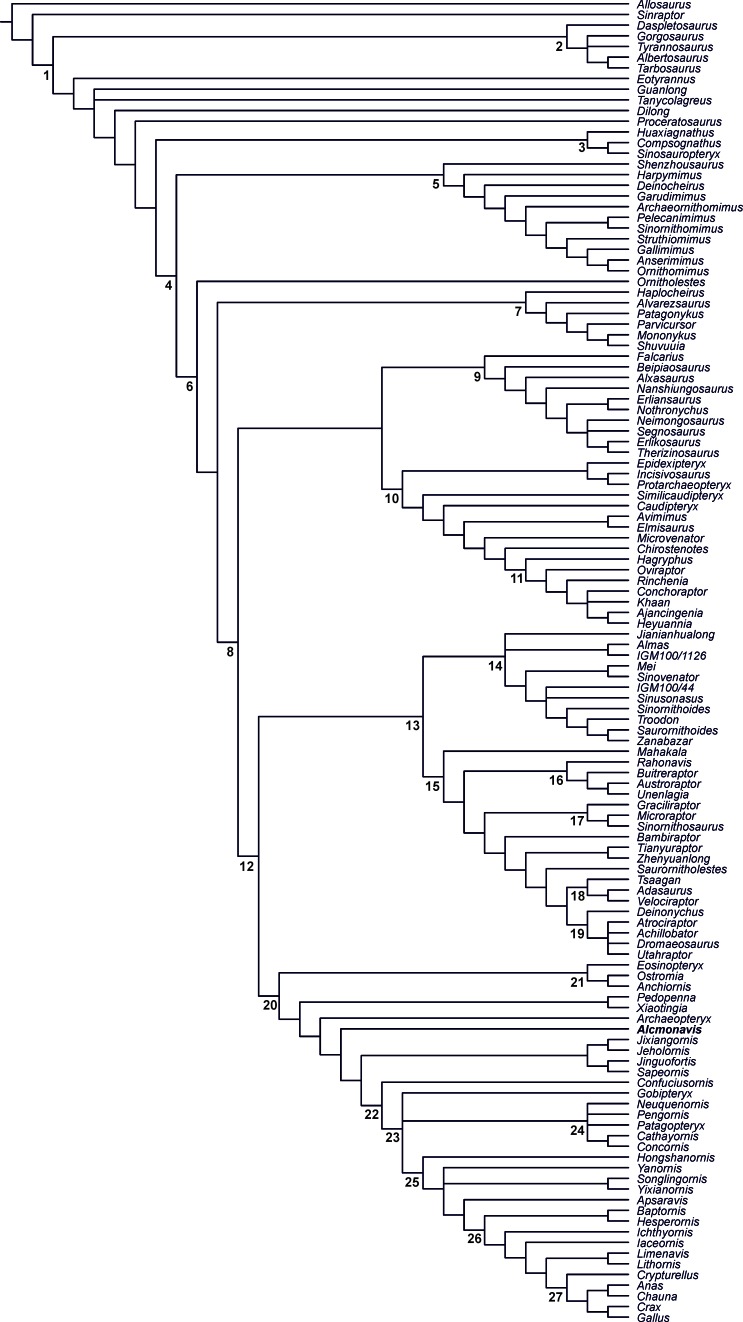
Full reduced consensus tree of the unweighted analysis.Named nodes: 1, Coelurosauria; 2, Tyrannosauroidea; 3, Compsognathidae; 4, Maniraptoriformes; 5, Ornithomimosauria; 6, Maniraptora; 7, Alvarezsauridae; 8, Pennaraptora; 9, Therizinosauroidea; 10, Oviraptorosauria; 11, Oviraptoridae; 12, Paraves; 13, Deinonychosauria; 14, Troodontidae; 15, Dromaeosauridae; 16, Unenlagiinae; 17, Microraptorinae; 18, Velociraptorinae; 19, Dromaeosaurinae; 20, Avialae; 21; Anchiornithidae; 22, Pygostylia; 23, Ornithothoraces; 24, Enantiornithes; 25, Ornithuromorpha; 26, Ornithurae; 27, Neornithes.